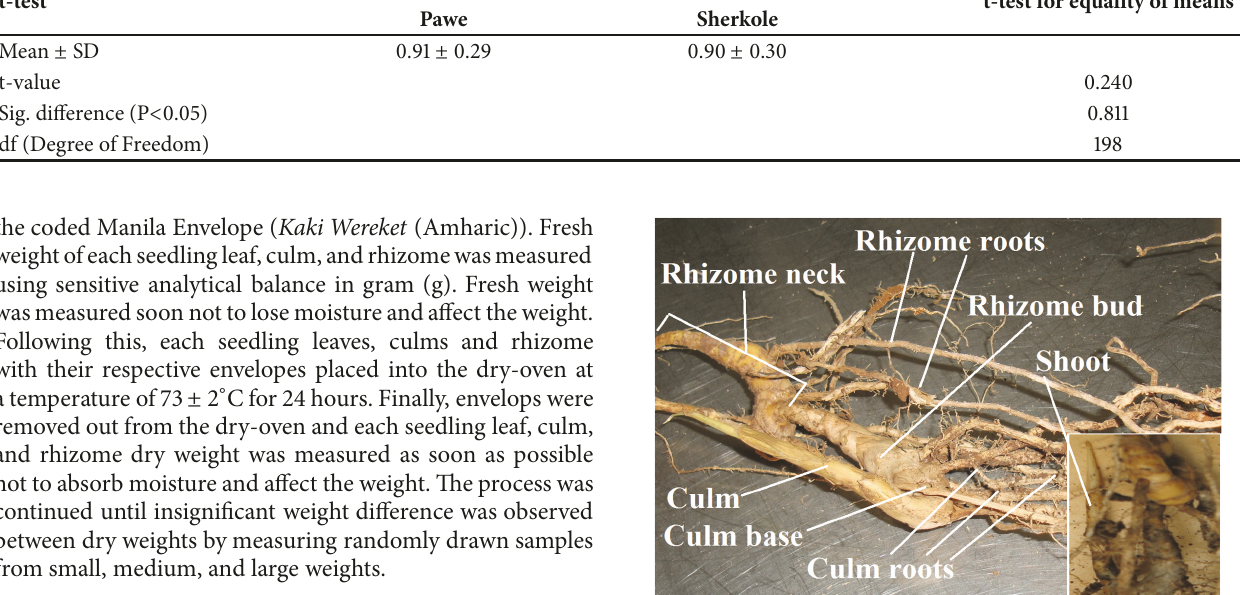
Table 2: Mean values of seedlings early survival rate between two O. abyssinica provenances (n=100, mean ± standard deviation (SD)). t-test